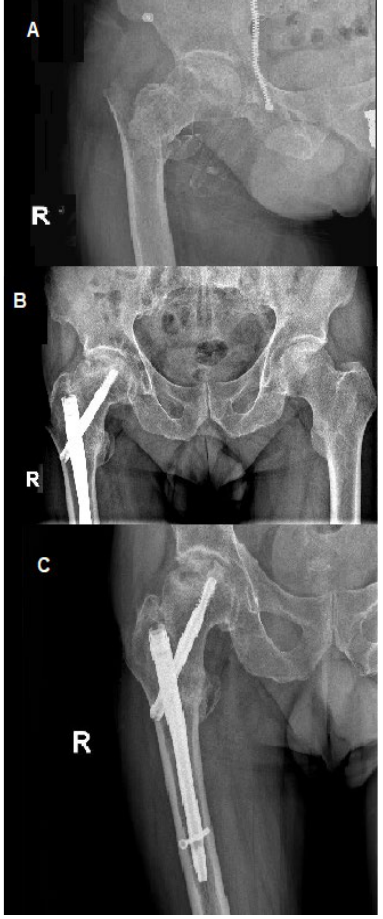
Figure 1. Avascular necrosis of right femoral head following stabilization of intertrochanteric fracture. ( A ) Posteroanterior view of the fracture; posteroanterior ( B ) view after 12 weeks of procedure; ( C ) view at a follow-up visit 20 weeks after the procedure, prominent necrosis of right femoral head; R—right.